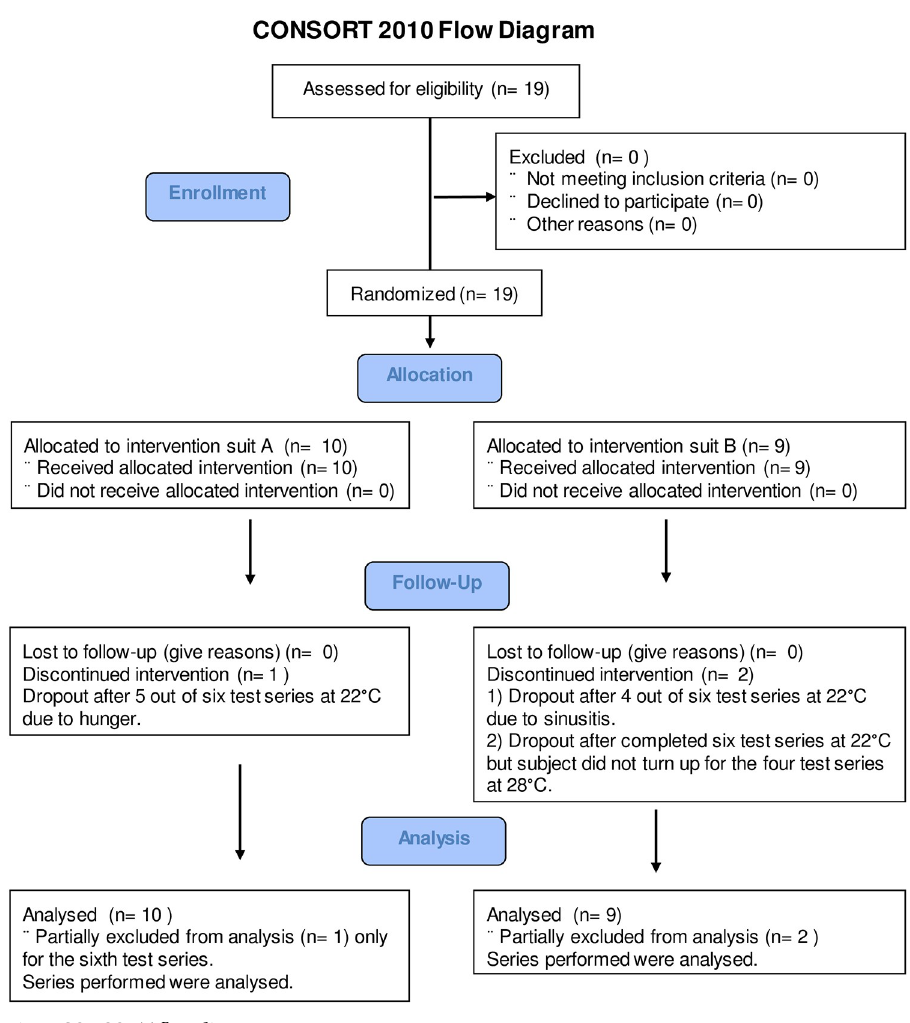
Fig 1. CONSORT flow